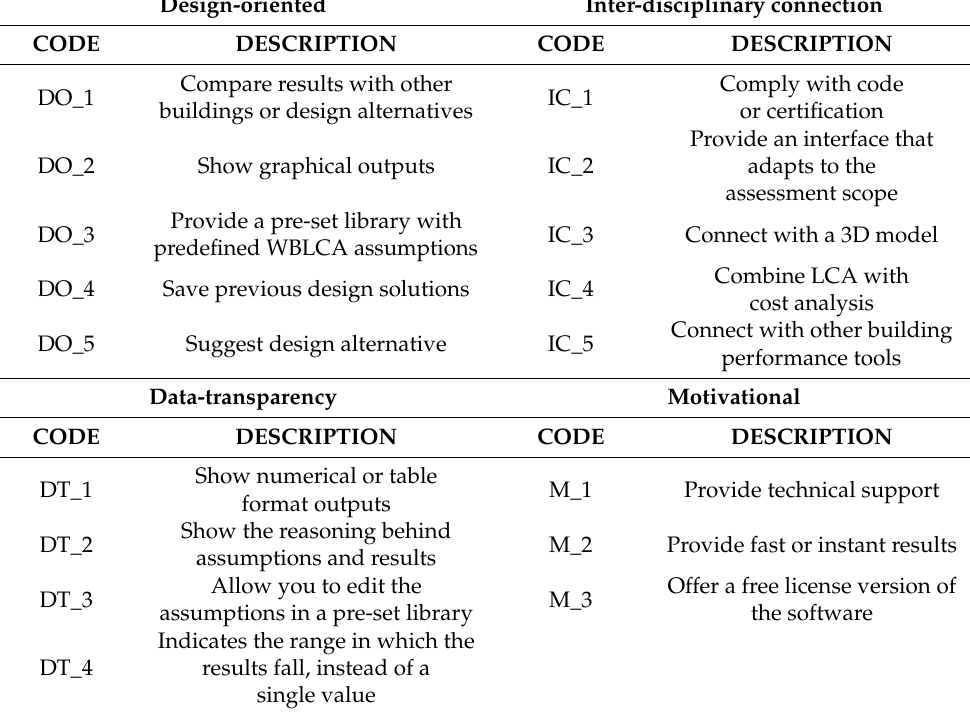
Table 1. List of attributes.